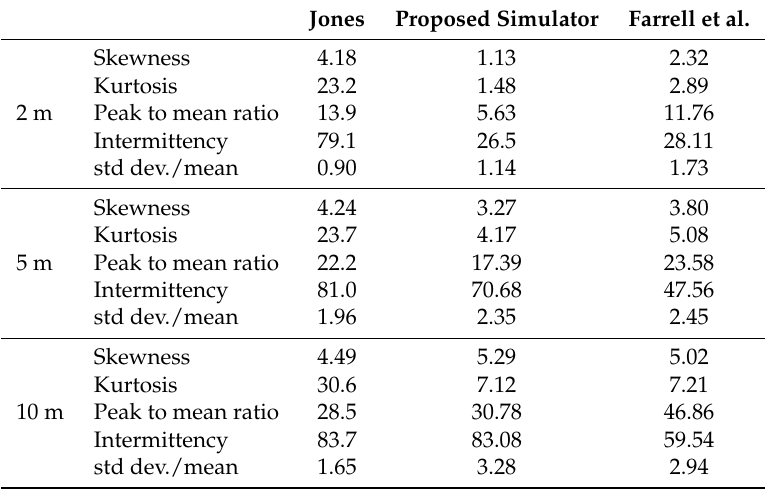
Table 6. Statistics of the odour plumes created in the real-world by Jones, modelled by Farrell et al. and simulated by the simulator proposed in this paper. The data is collected using a 1 Hz filter bandwidth. It is presented in three lines, respectively corresponding to the sensors at 2 m, 5 m and 10 m downwind from the chemical source. Jones Proposed Simulator Farrell et